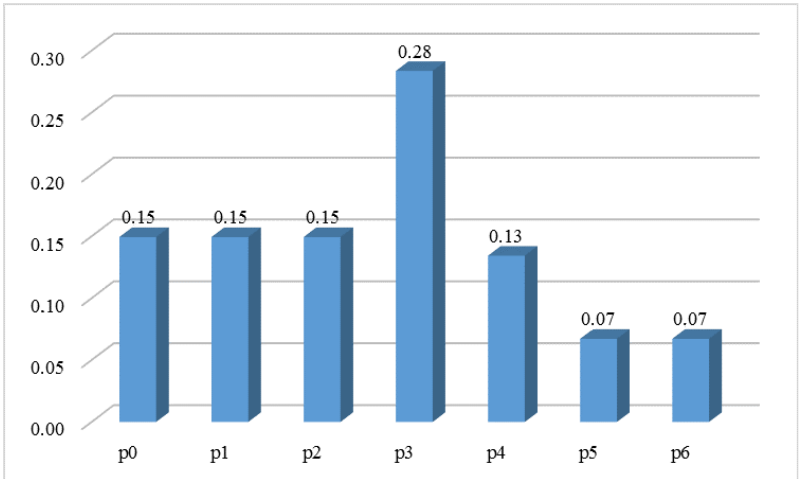
Figure 7. Average estimates for the final probabilities in the implementation of a complete factor plan with values a = 0.1 ÷ 1.0 ( Δ = 0. 1) и b = 0.3 ÷ 0.7 ( Δ = 0.1).